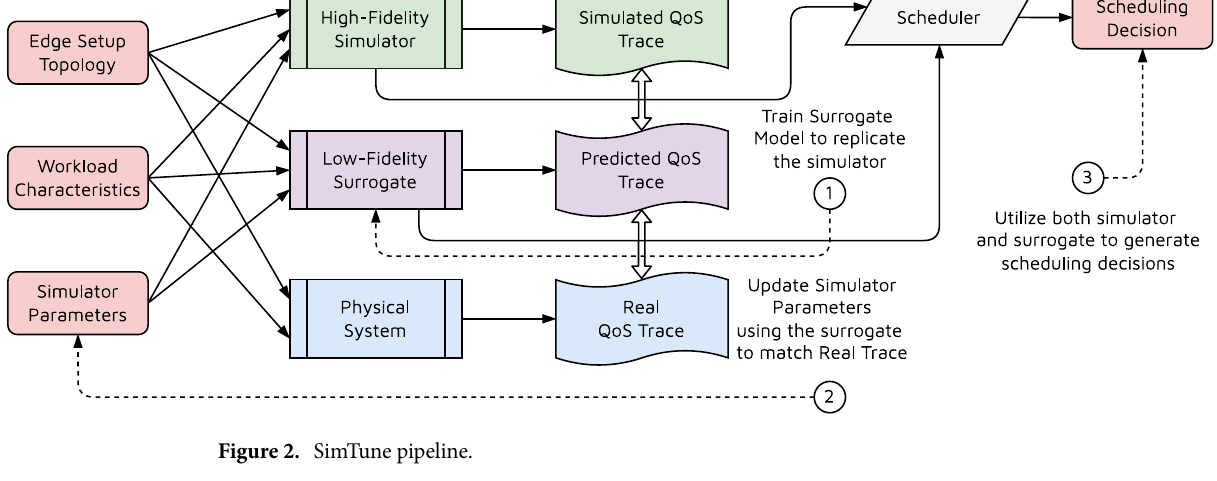
Figure 2. SimTune